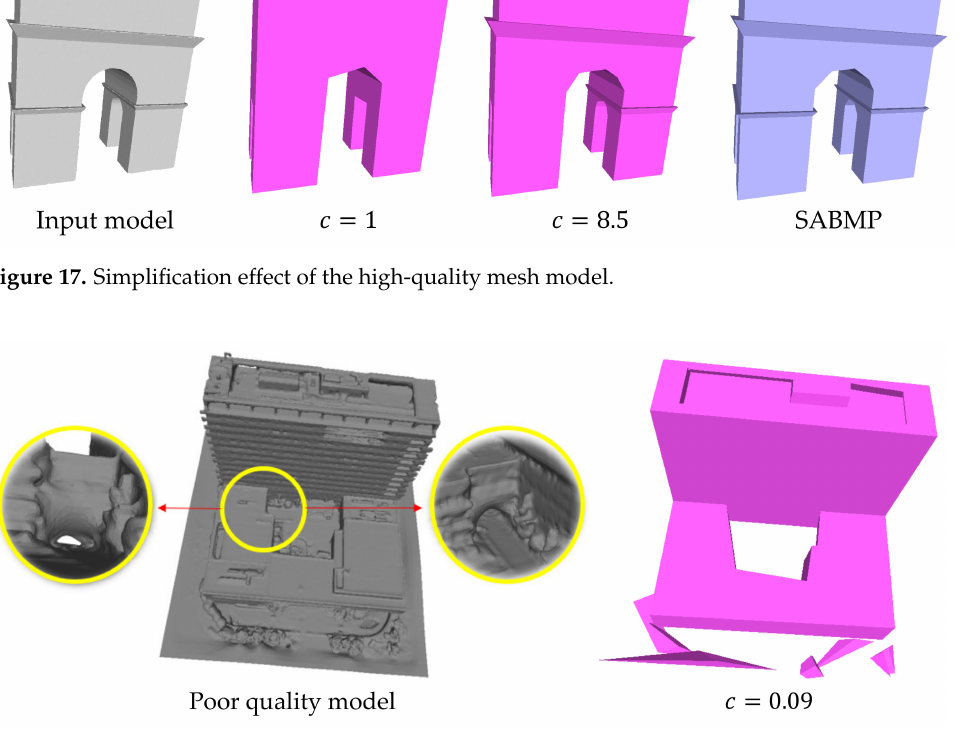
Figure 18. Simplification of the poor-quality mesh model. In the area of the yellow circle, there are the regions that are prone to failure of simplification and the enlarged view from different angles.